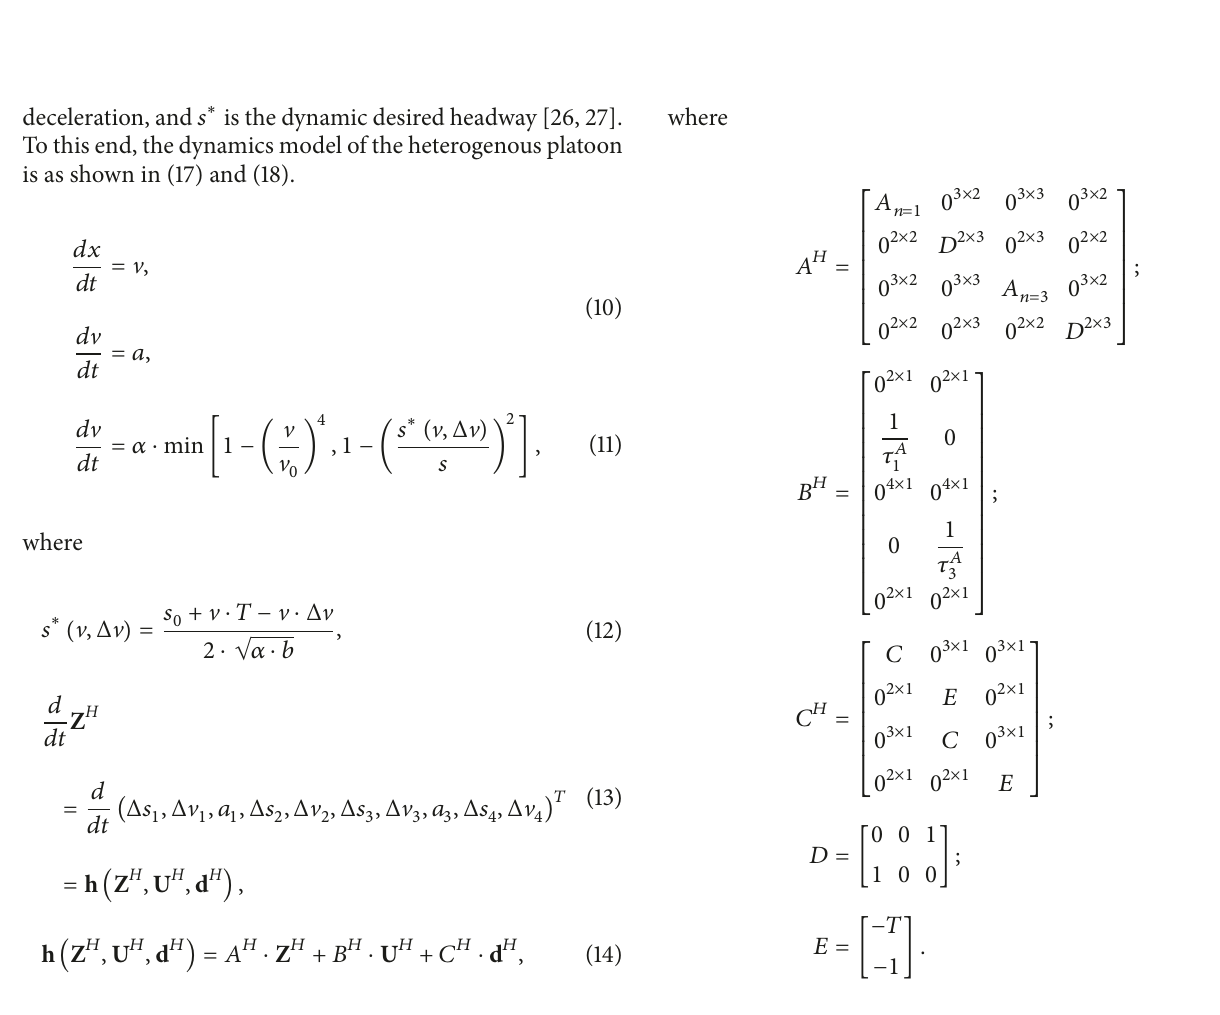
Figure 1: The platooning